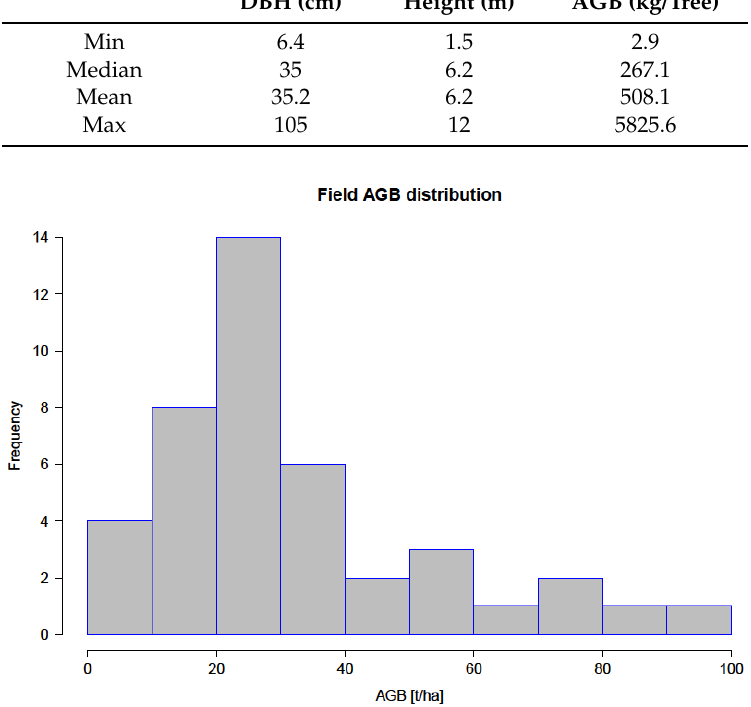
Table 3. Summary statistics of the inventoried trees. DBH = diameter at breast height; AGB = aboveground biomass.